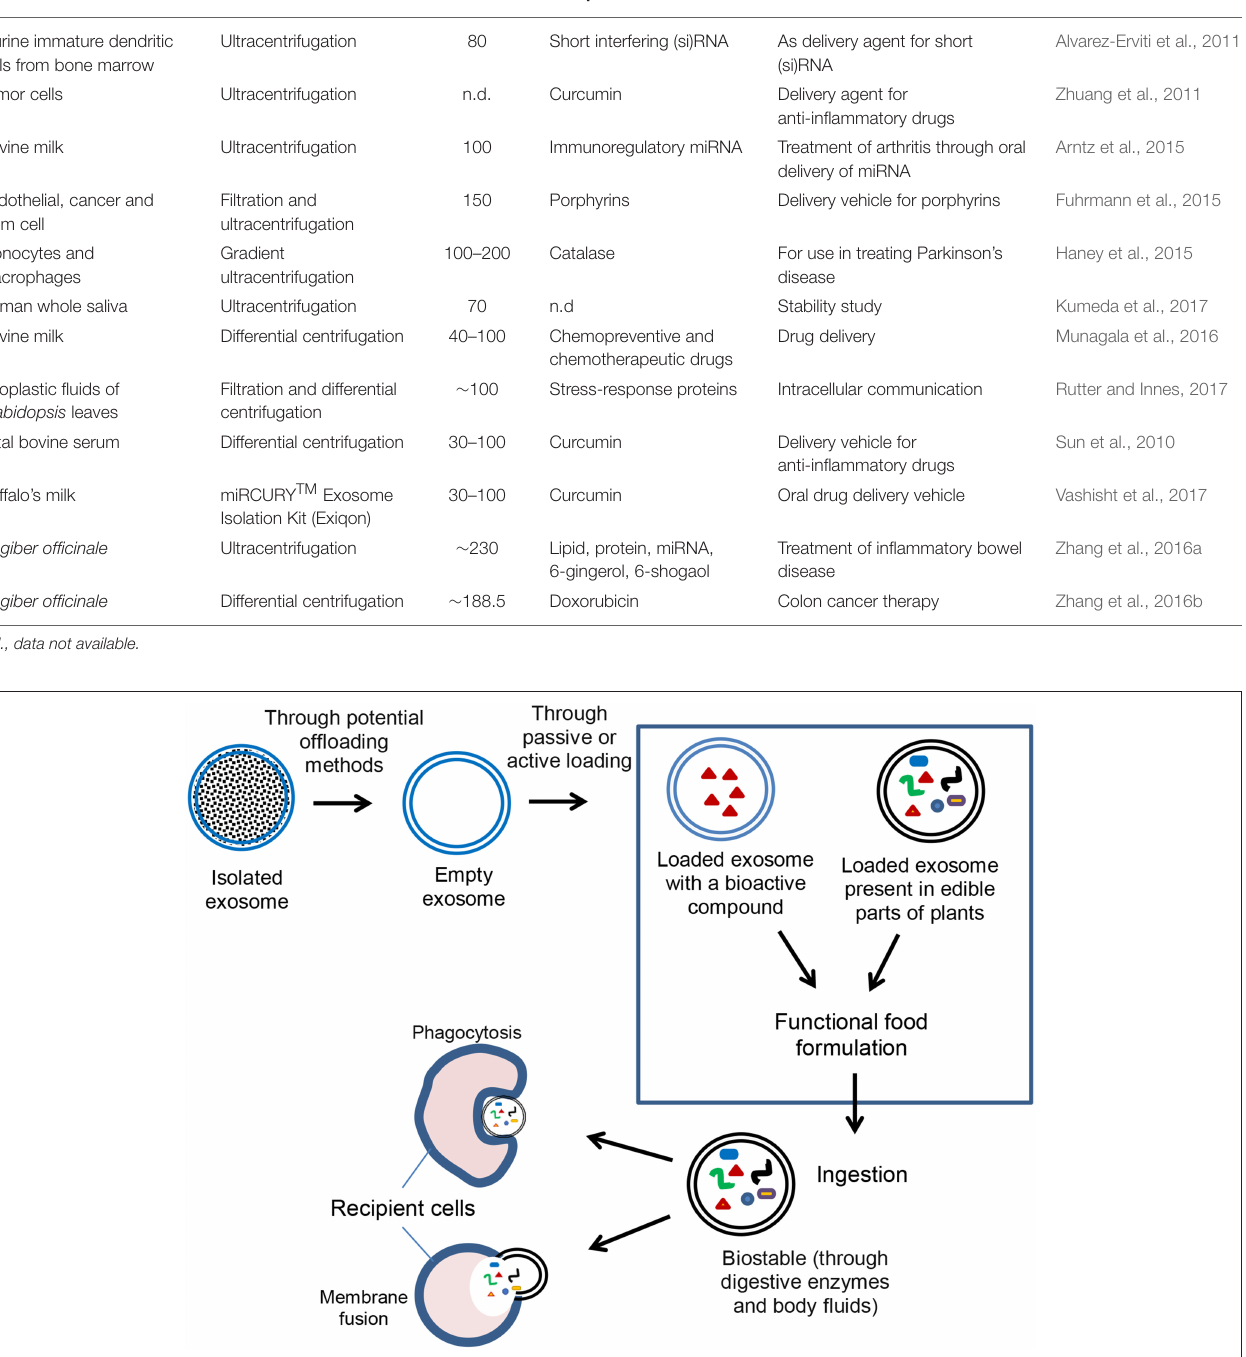
FIGURE 3 | Potential application of exosomes in encapsulation and delivery of bioactive